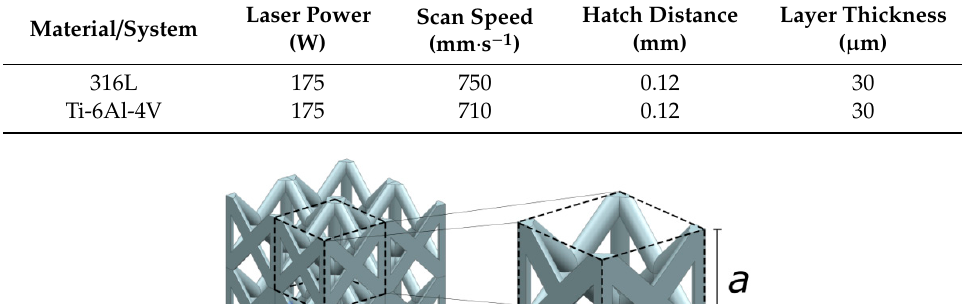
Table 4. Material properties considered in present work.